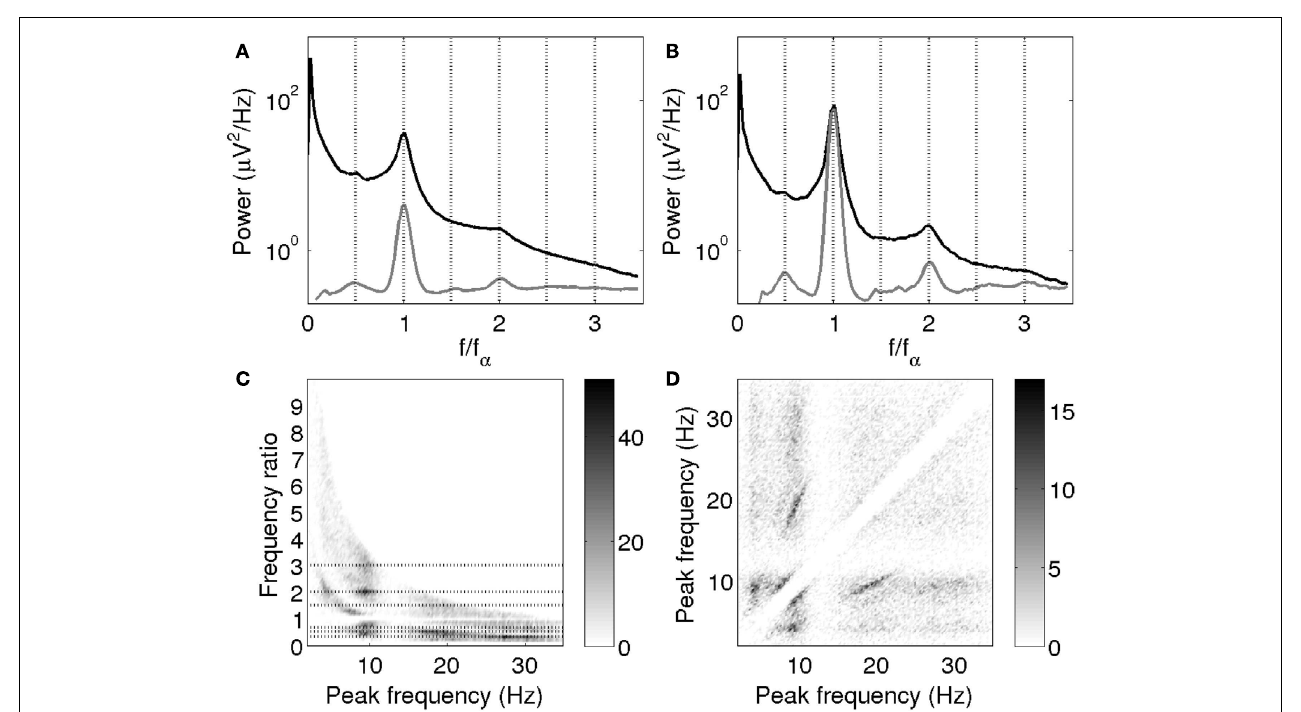
frequencies within spectra. Dotted lines are drawn at 1/3, 1/2, 2/3, 3/2, 2, and 3. (D) Pairs of peak frequencies within spectra.The grayscales indicate the density of points.The empty diagonal band reflects the omission of the 1:1 points and the separation necessary for peak